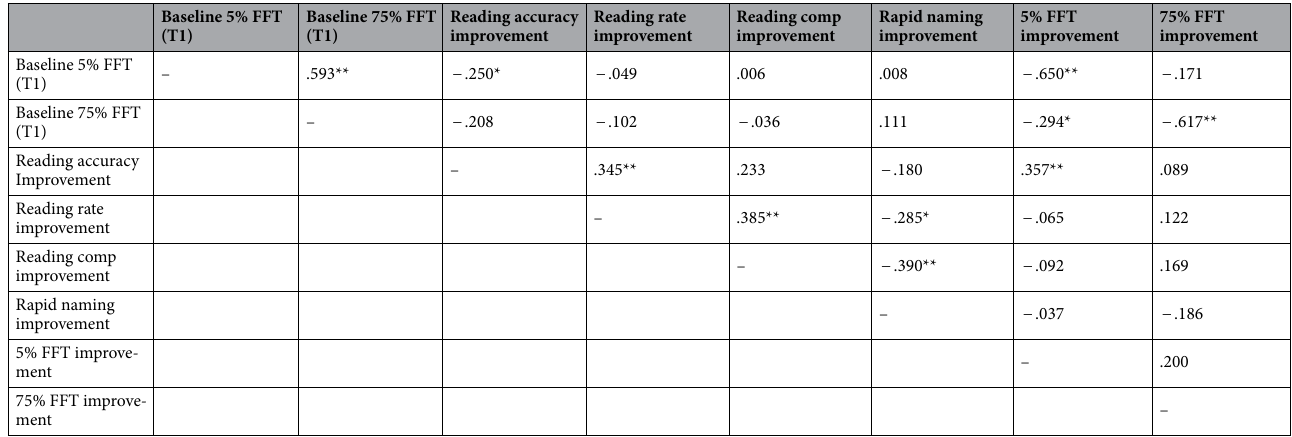
Table 3. Correlations between flicker fusion performance and reading improvement scores. According to Cohen’s guidelines, r ≥ 0.10, r ≥ 0.30, and r ≥ 0.50, represent small, medium, and large effect sizes,